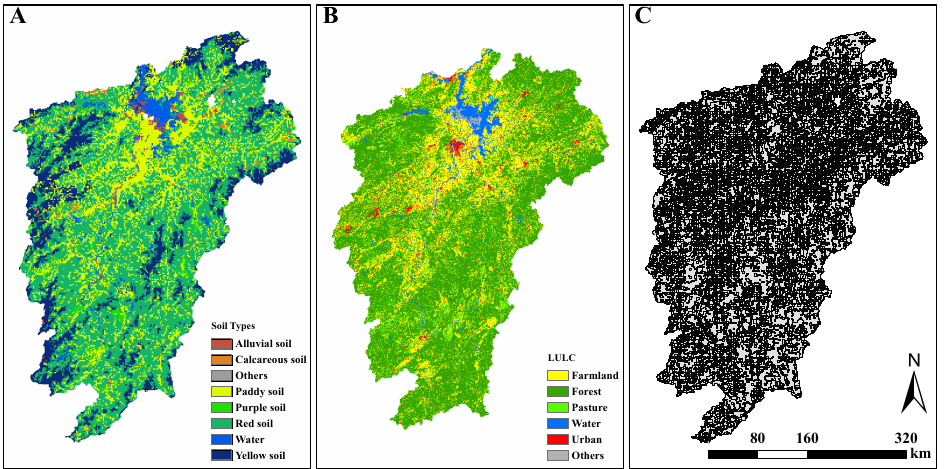
Figure 5. Characteristics of the Poyang Lake Basin: ( A ) Soil types; ( B ) Land use and ( C ) the hydrological response